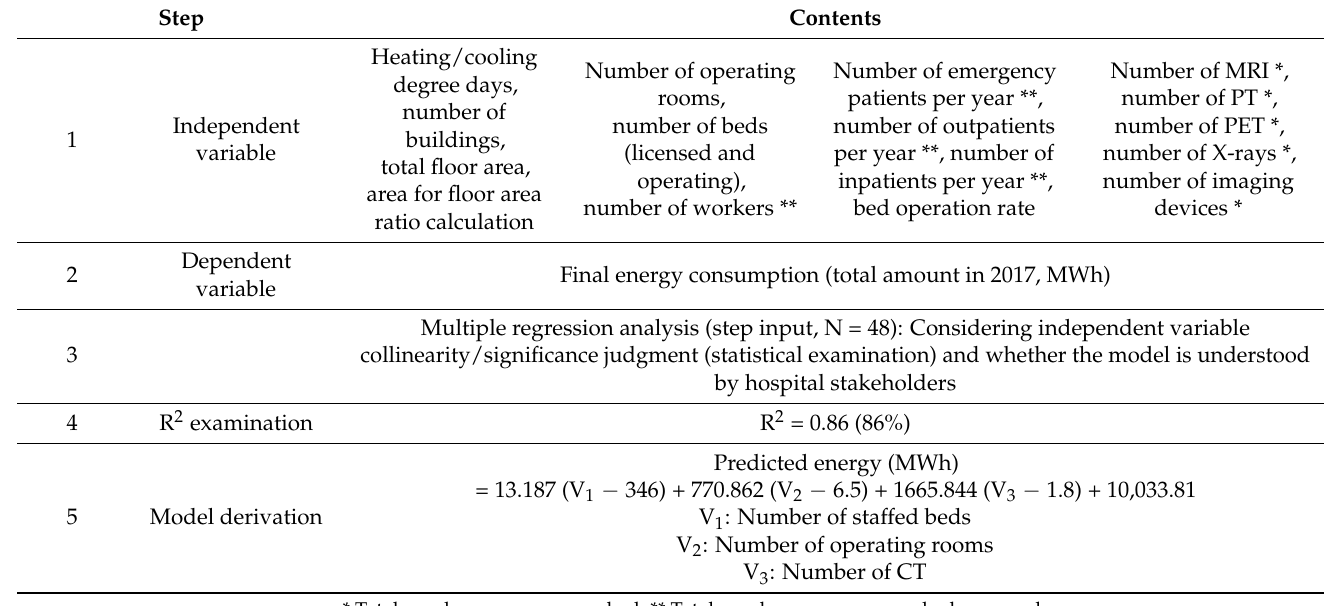
Table 10. Multiple regression analysis process using business activity data of